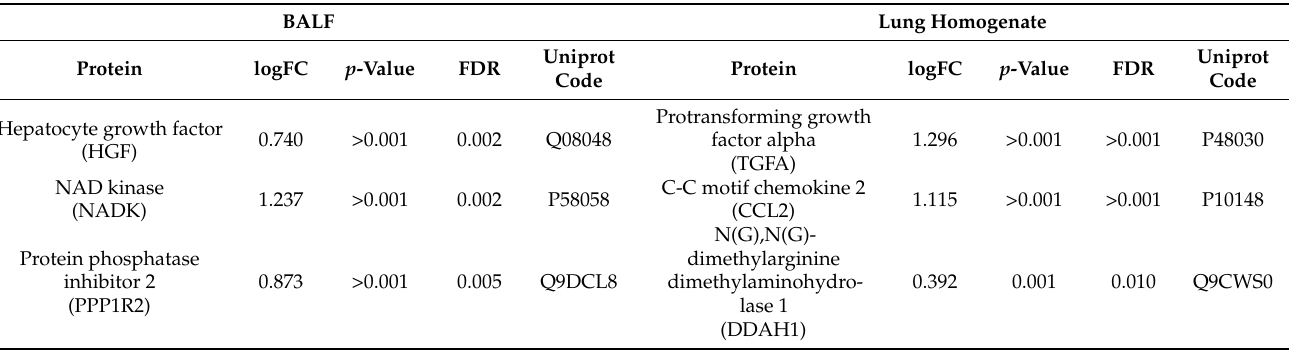
Table 1. Top table of BALF (left) and lung homogenate (right) protein expression. Significant proteins are shown. The p -value column corresponds to the unadjusted p -value. logFC: logarithmic fold-change, FDR: false discovery